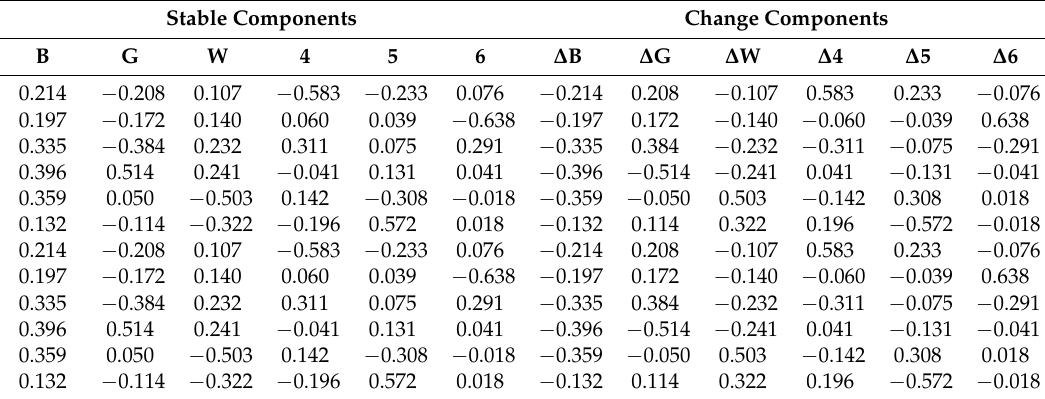
Table 1. Multitemporal Kauth-Thomas transformation matrix for Landsat 8 OLI reflectance data. Components B = brightness, G = greenness, W =